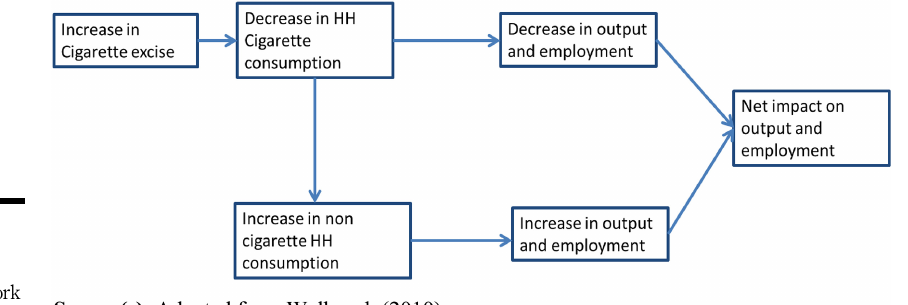
Figure 1. Estimation